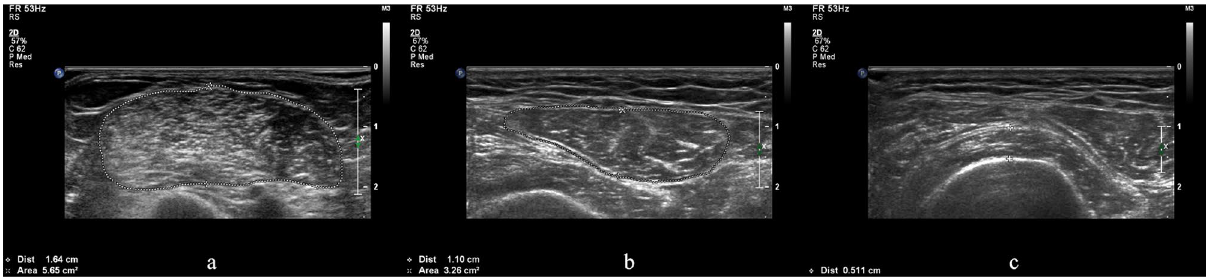
Figure 1. Ultrasound appearance of muscle thickness and cross-sectional area. Appearance and ultrasound measurement of thickness and cross-sectional area of biceps brachii muscle ( a ), rectus femoris muscle ( b ), and vastus intermedius muscle ( c